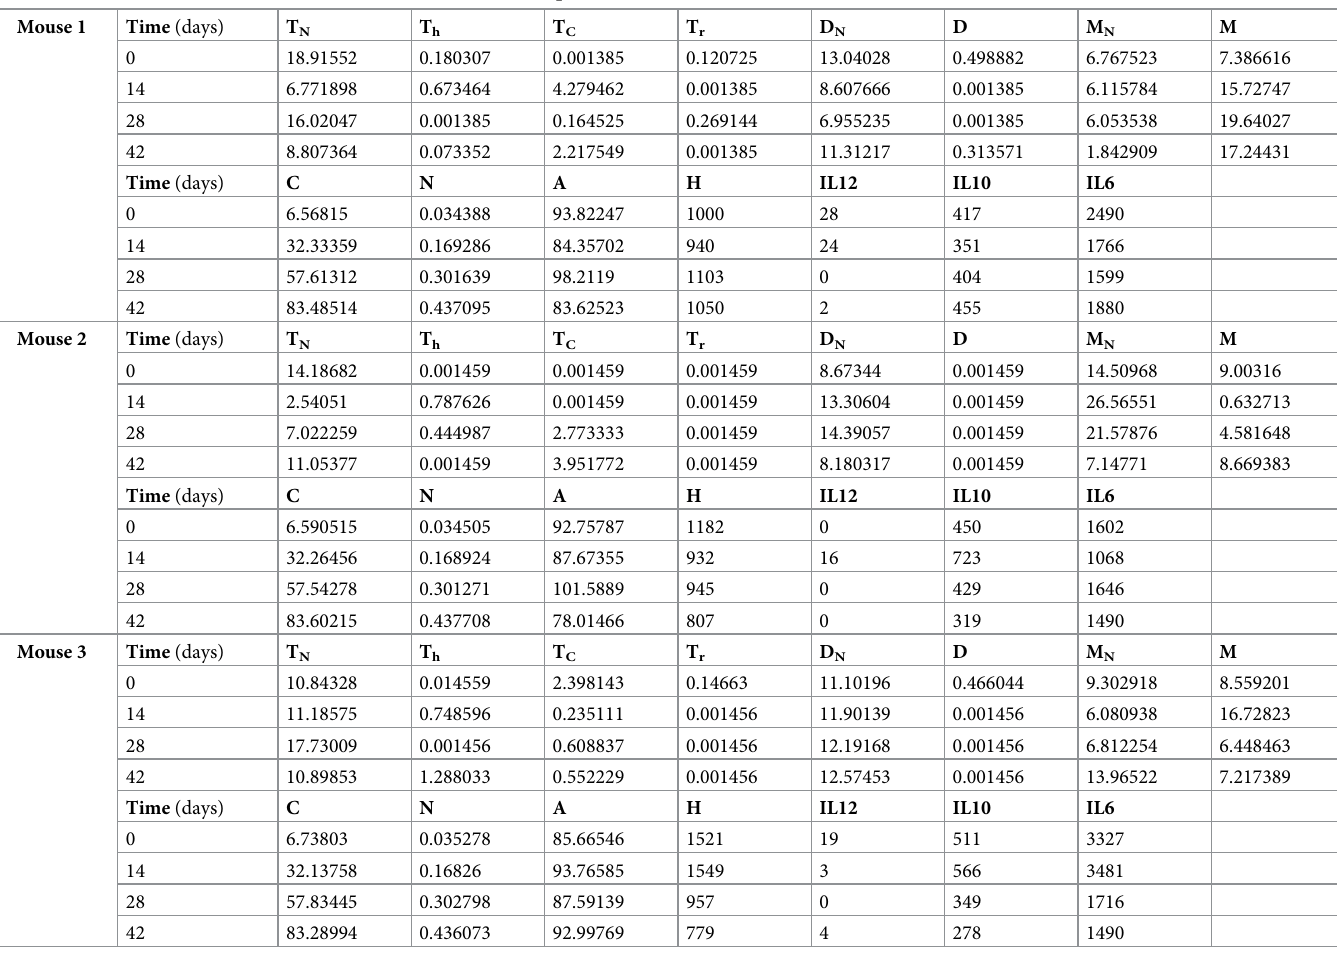
Table 2. Cells and molecules values for each mouse at different time